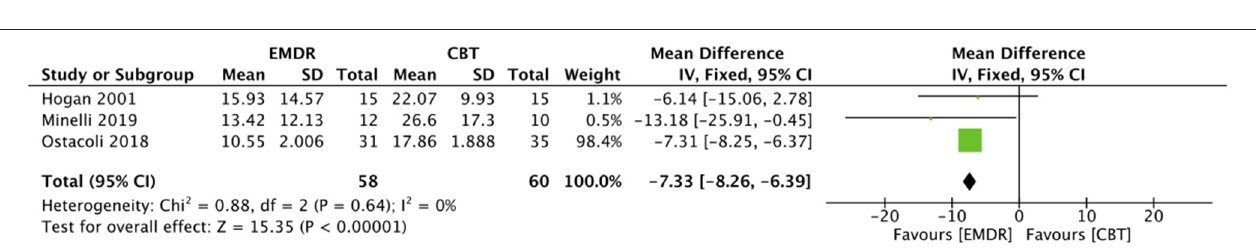
Comparison 2: EMDR vs.